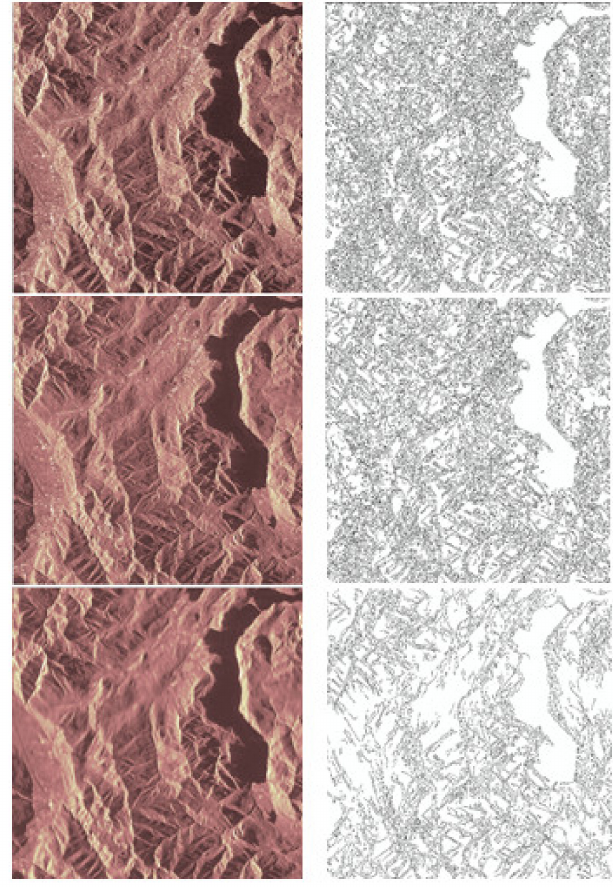
Figure 7. Results of the proposed edge detection method applied to an aerial SAR image. Left column, up to down: original image; first stage denoising result; final denoising result. Right column, up to down: edge maps of corresponding images obtained applying the Canny’s detector.